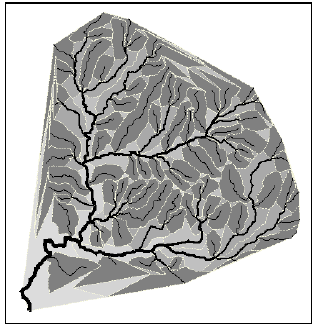
Figure 5 Hierarchical partitioning of river catchment